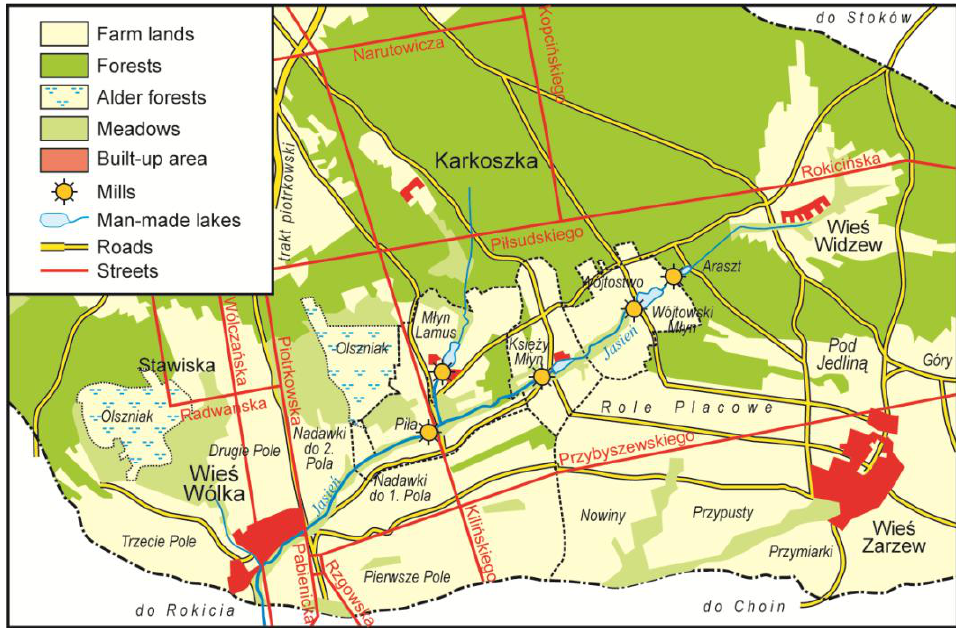
Fig. 3. River Jasień valley at the beginning of the 19 th century (source: Szkurłat,